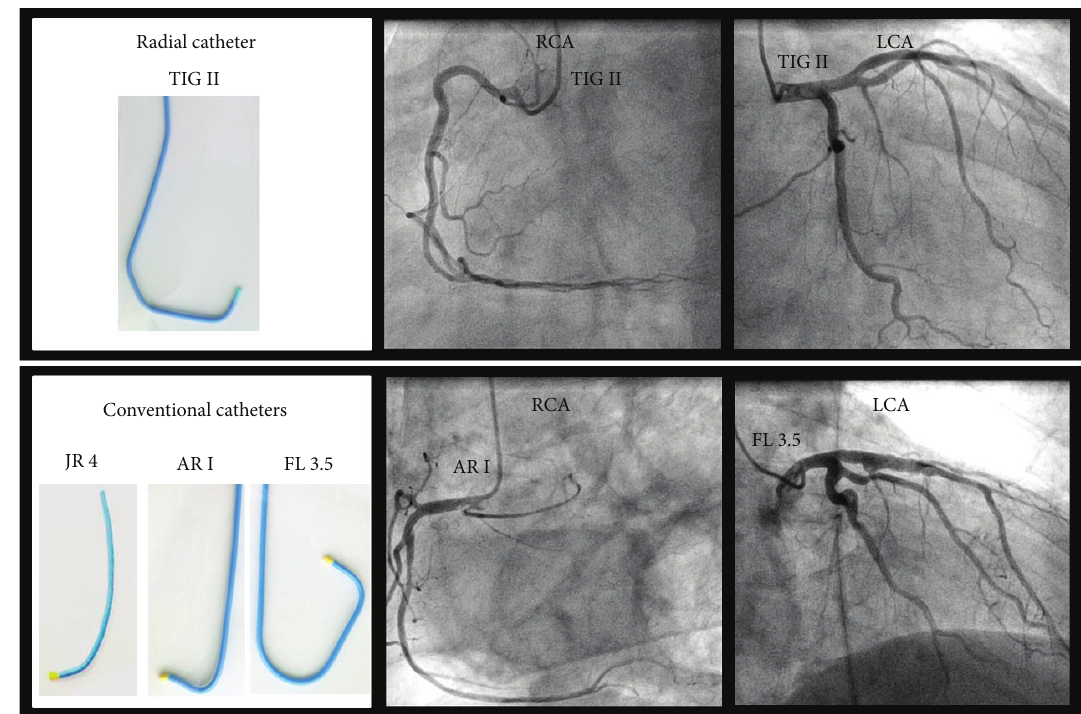
Figure 1: Design and performance of radial (TIG) and conventional (CONV)